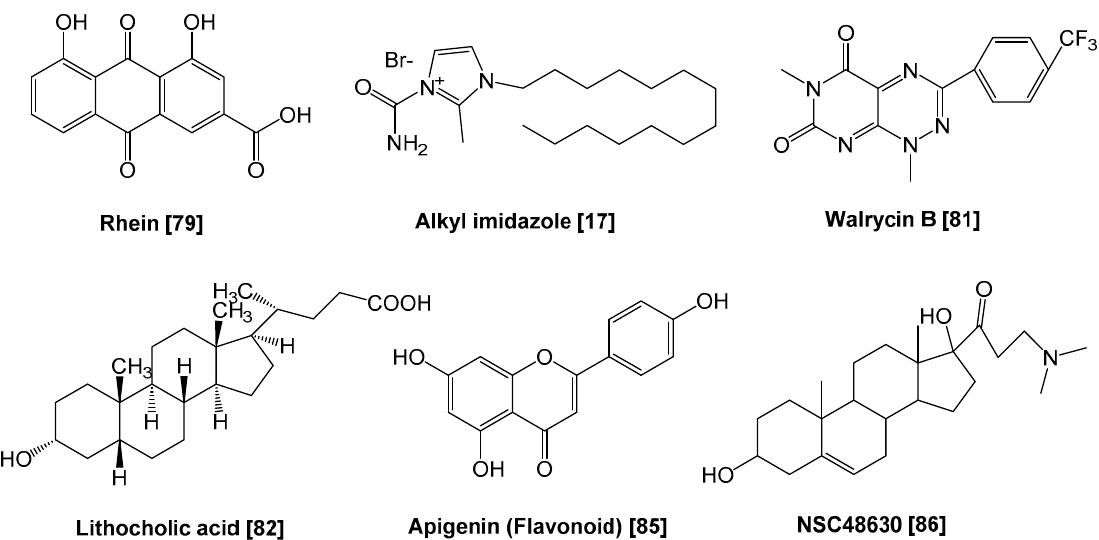
Figure 3. Chemical structures of representative response regulator inhibitors.